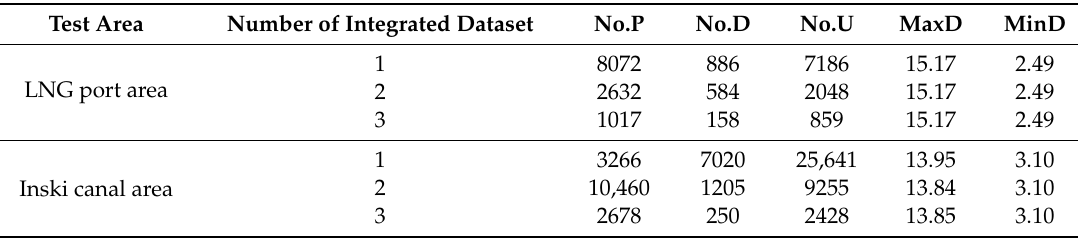
Table 6. Statistics for integrated datasets.